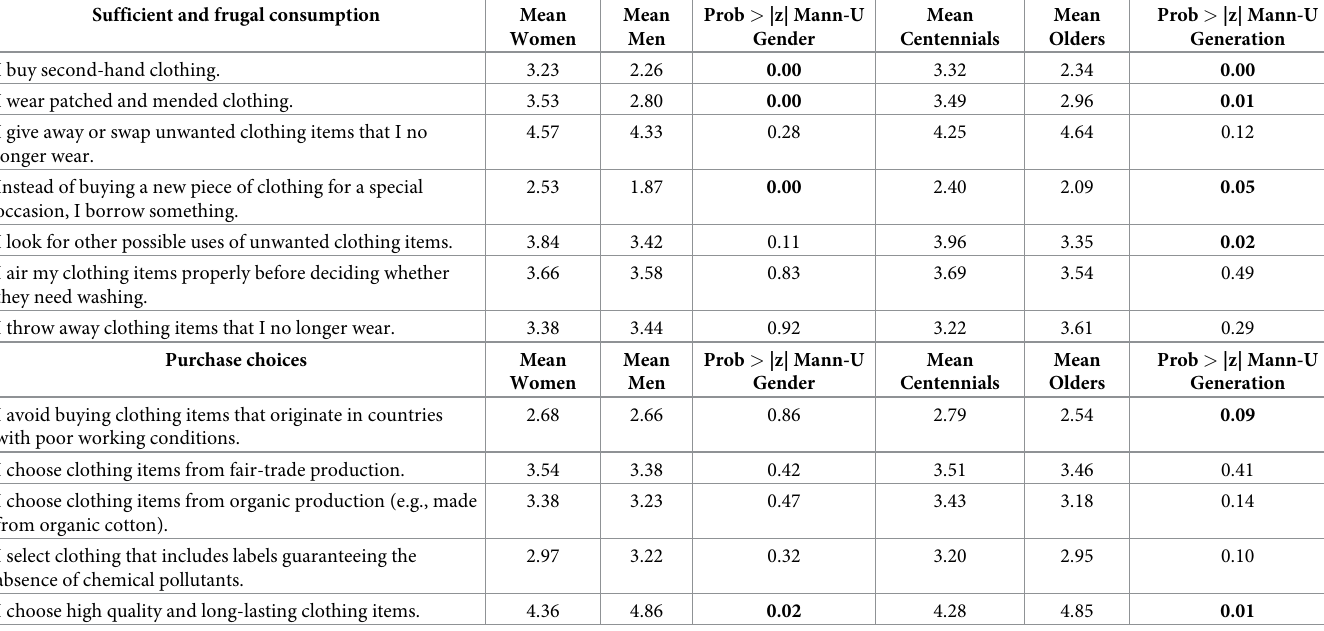
Table 2. Comparison of central tendency by